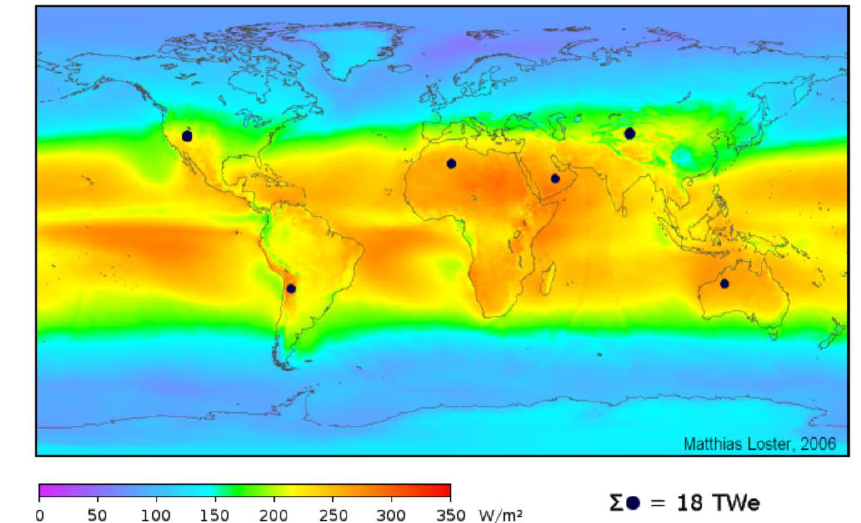
Figure 8. Distribution of solar radiation in the world (Reproduced with permission from [68]. Matthias Loster, 2010).